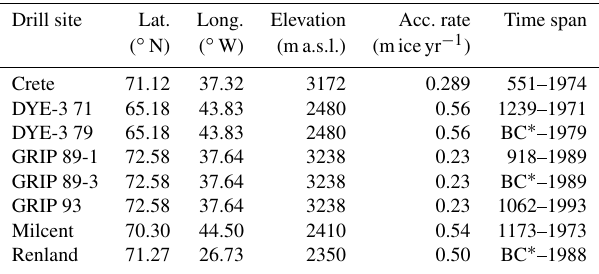
Table 2. Site details of ice core records used for the reconstruction (Vinther et al., 2010). BC* indicates the at the core was drilled to